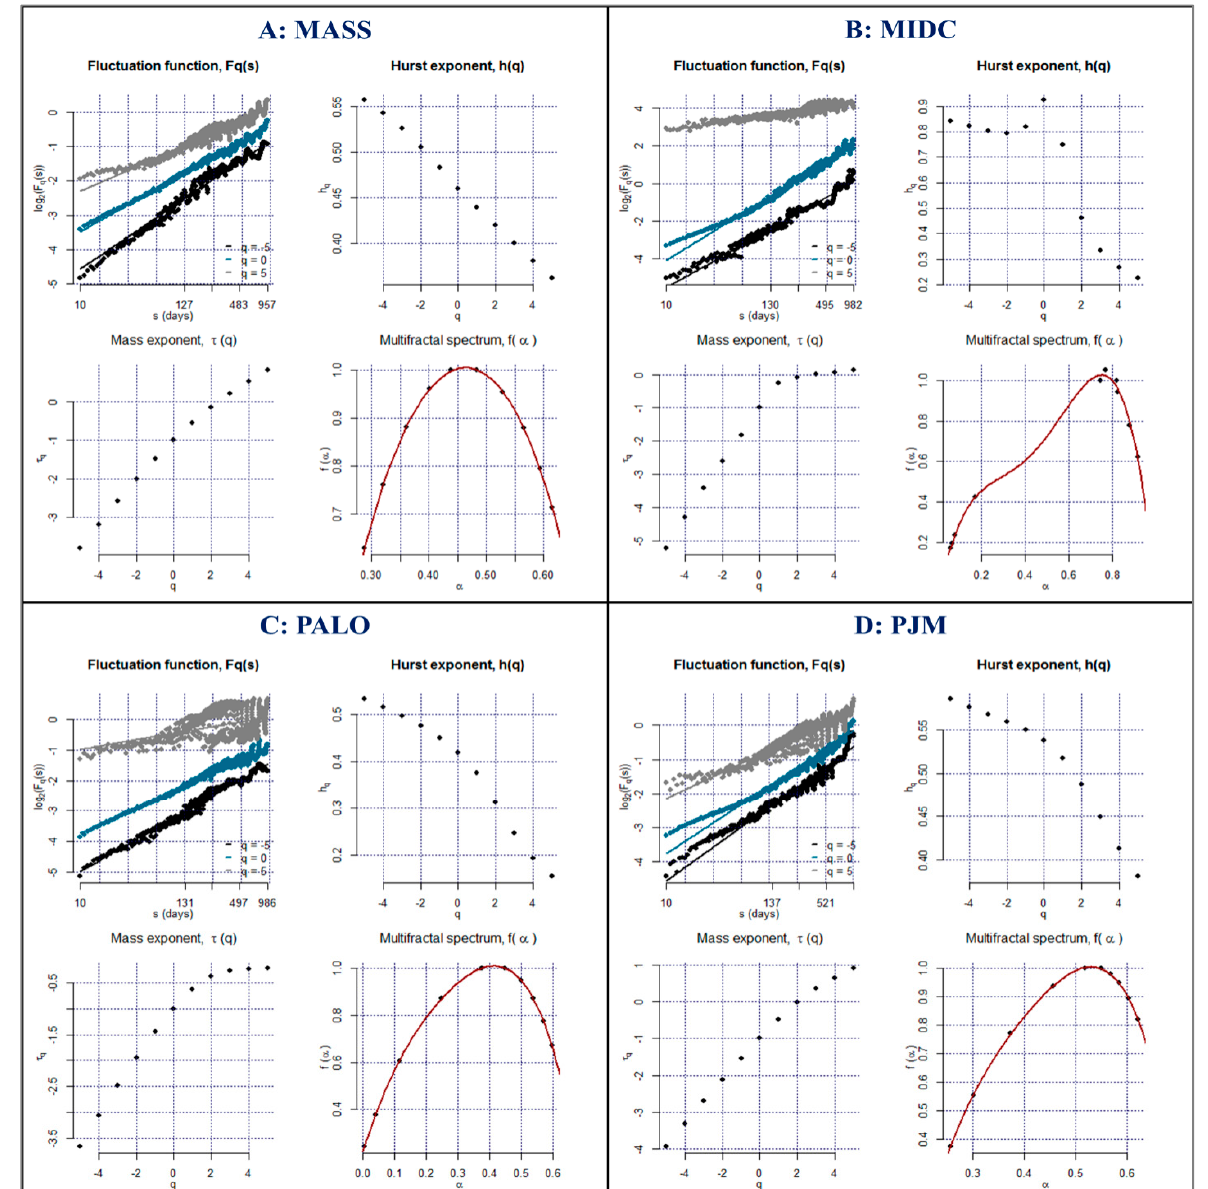
Figure 2. The Multifractal detrended fluctuation analysis (MFDFA) findings of electricity indices. The Fluctuation functions for q = 5, q = 0, and q = 5 are displayed at the top left. The top right shows the Generalized Hurst exponent for each q . The Mass exponent, τ ( q ) , is presented at the bottom left, and the bottom right shows the Multifractal spectrum. The market’s codes are presented in Table 1.